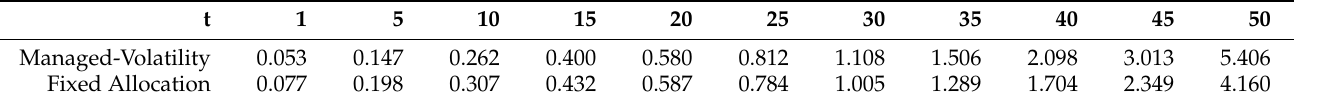
Table 6. Coefficient-of-Variation of Annuity Payments.